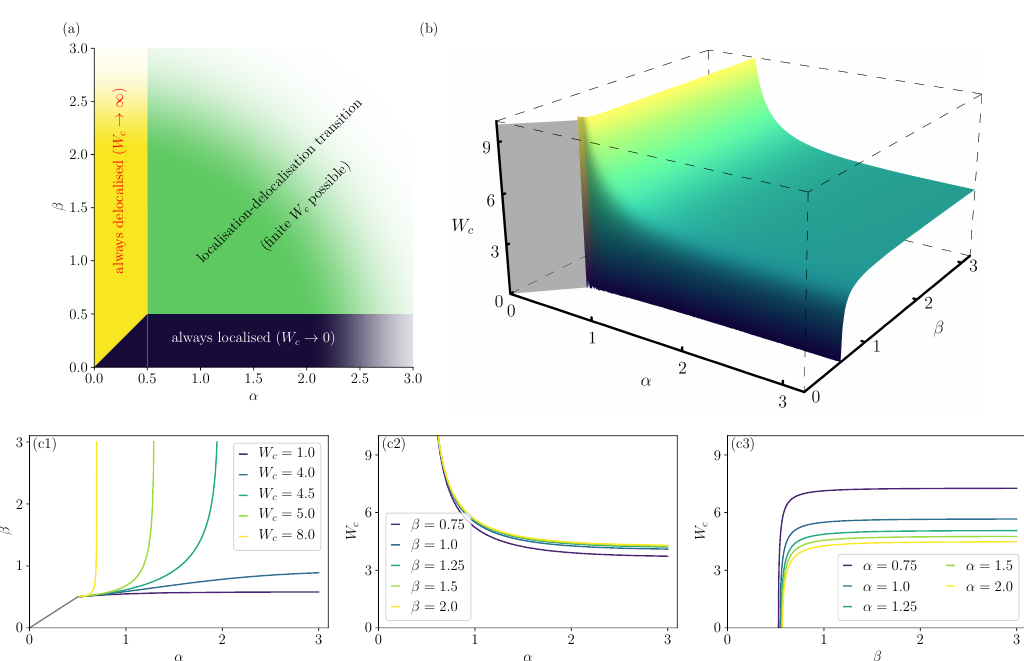
Figure 2: Mean-field phase diagram: (a) Schematic of the phase diagram in the α - β plane obtained from the scaling of Γ 2 and µ 2 with N in the thermodynamic limit. ˜ E Within the yellow [ dark blue ] region the system is always delocalised [ localised ] , as the critical disorder diverges [ vanishes ] in the thermodynamic limit. In the green region, both Γ 2 and µ 2 scale in the same way with N , and there is thus a finite critical ˜ E disorder. Note that the boundaries between the green and the yellow [ dark blue ] regions corresponding to α = 1 / 2 [ β = 1 / 2 ] are not phase boundaries (critical lines), but simply represent no-go regions for the localised [ delocalised ] phases. The actual critical lines on the α - β plane (which depend on the disorder strength) are shown ( α , β ) , obtained from the mean-field in (c1). (b) The critical disorder surface, W c = J ( ≡ 1). The region treatment, Eq. (42), shown as a function of α and β , with J z above and below the surface corresponds respectively to localised and delocalised phases. (c1)-(c3) Sections of this surface are shown in their complementary planes of constant W , β and α . The constant W contours (c1) in the α - β plane shift towards c c low α and high β regions as W is increased (the localised phase lies below and to c the right of the lines shown). The constant β contours (c2), and constant α contours (c3), clearly show respectively that W increases with decreasing α , and decreases c with decreasing β